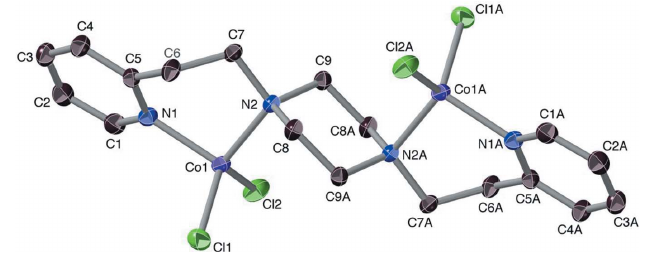
Figure 2 Molecular structure of Co 2 (Ppz)Cl 4 . Ellipsoids are drawn at the 50% level, and for clarity of presentation, H atoms are omitted. The two half- molecules in the structure are symmetry equivalent and are related to the other halves via the symmetry operation (1 (cid:2) x , 1 (cid:2) y , 2 (cid:2) z ).